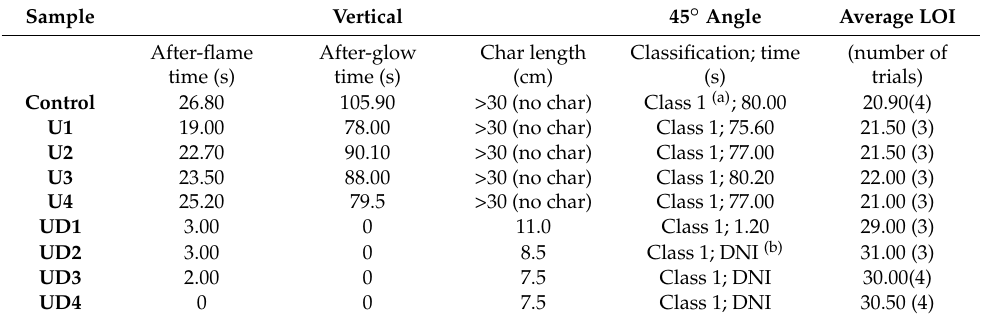
Table 3. Vertical flammability (ASTM D-6413-11), 45 ◦ angle flammability (ASTM D-1230-01) and LOI (ASTM D-2863-09) tests for different add-ons (wt%) of treated fabrics. All values for vertical and 45 ◦ angle tests are averages from two observations.